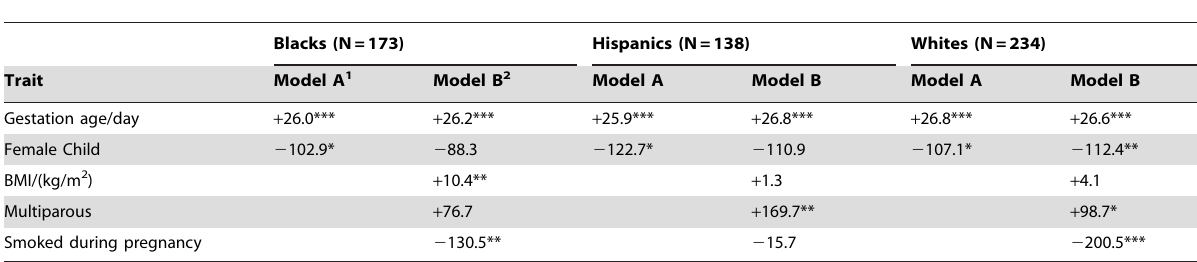
Table 2. Risk factor effects on birth weight in